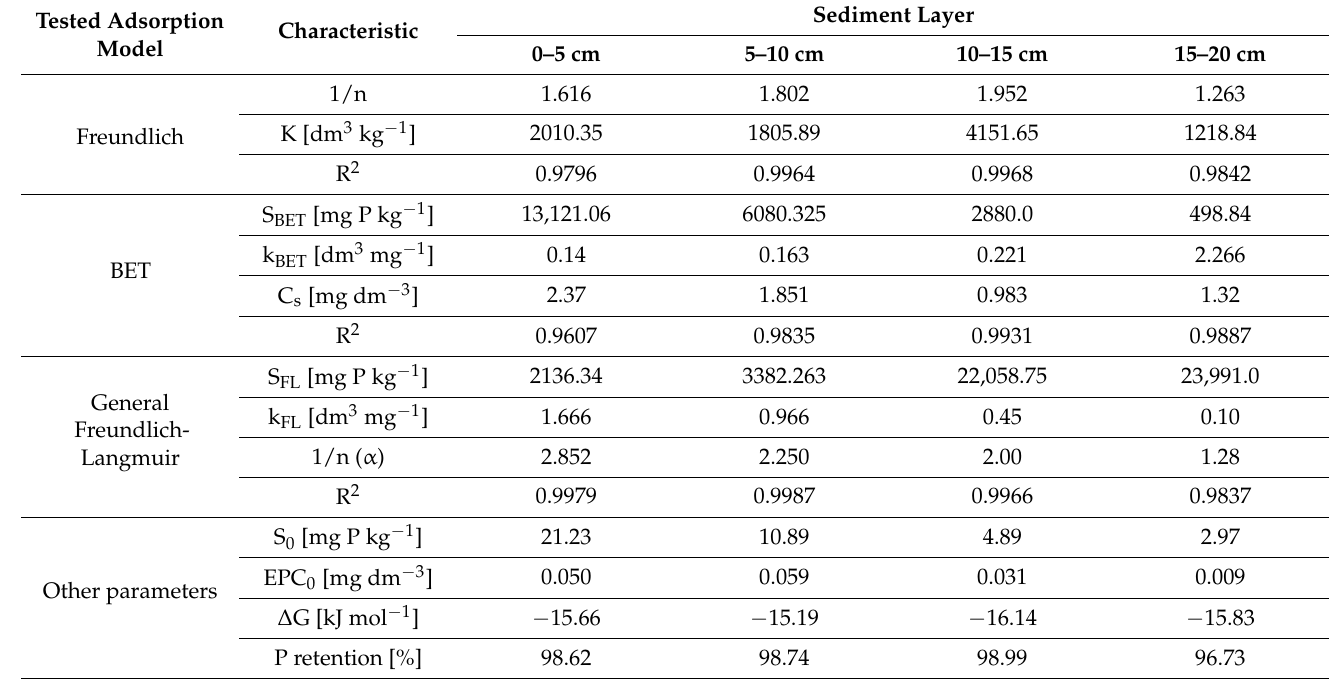
Table 4. P adsorption characteristics of bottom sediment of Lake Kortowskie at St. 2